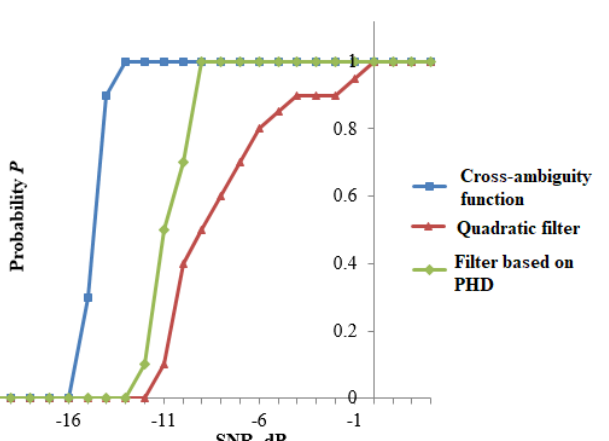
Fig. 5. The dependency P (SNR) for the proposed algorithms and the algorithm base on calculation the cross-ambiguity